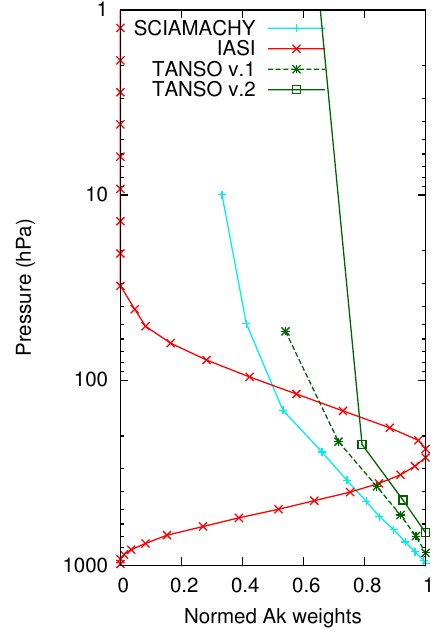
Figure 3. Example of averaging kernels (cyan: SCIAMACHY, dotted green: TANSO v.1 and full green: TANSO v.2.0) and weighting function normalised by it maximum value (red: IASI) of the CH 4 products from the different instruments.